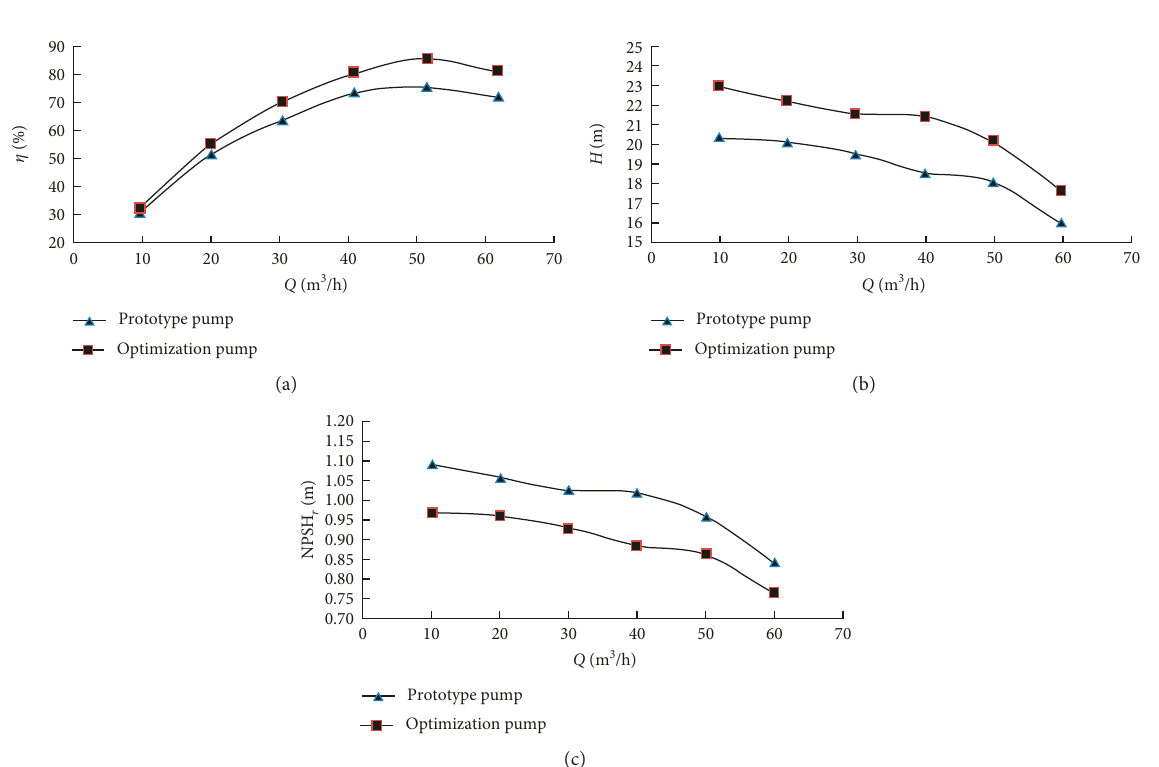
Figure 10: External characteristic curves of prototype pump and optimization pump. (a) η - Q , (b) H - Q , and (c) NPSH